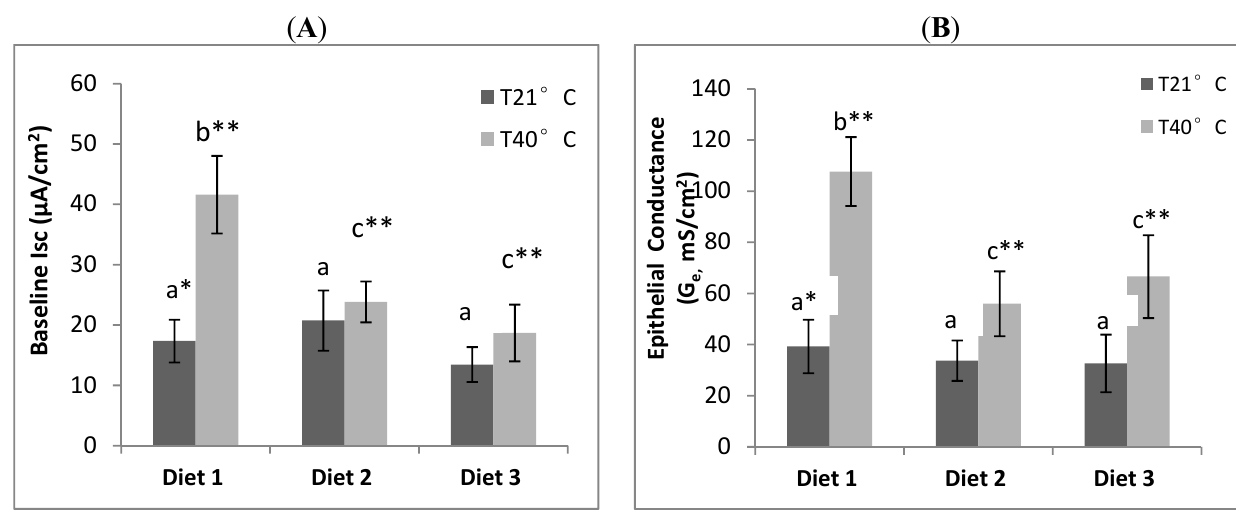
** Mean values showing statistical significant effect relative to the control (*) ( p < 0.05,